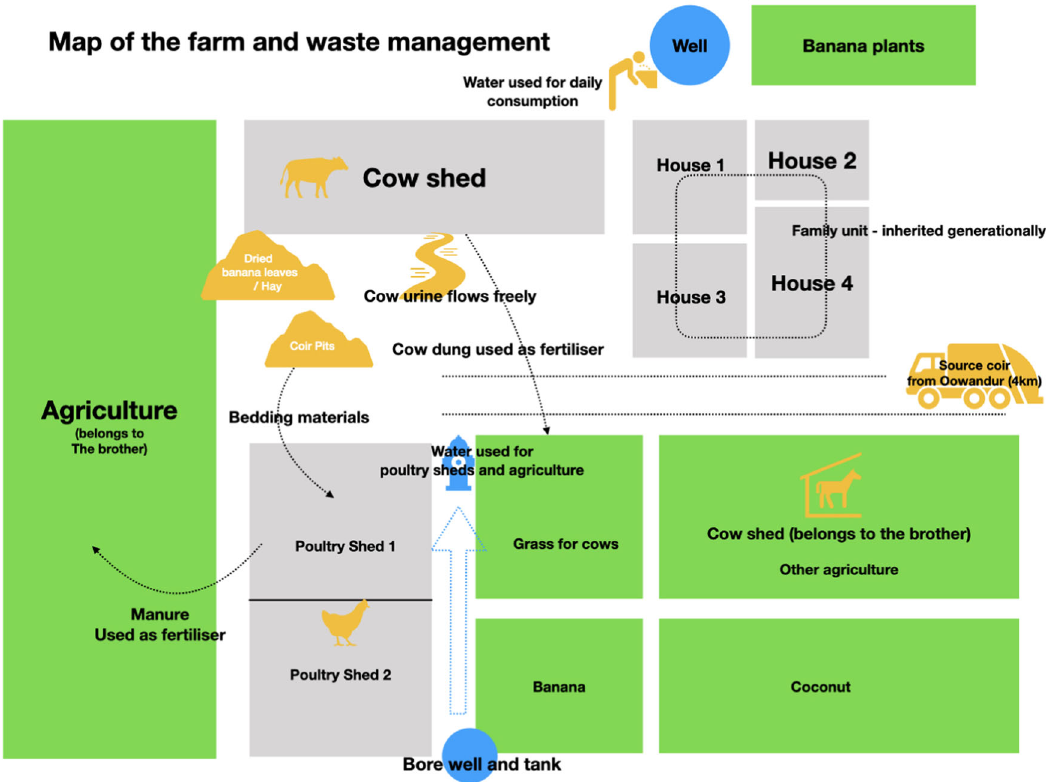
Fig. 4 Spatial map of a farm. This participatory map was designed by walking around and discussing aspects of the farm with the farmer. We carried out this mapping exercise on each farm